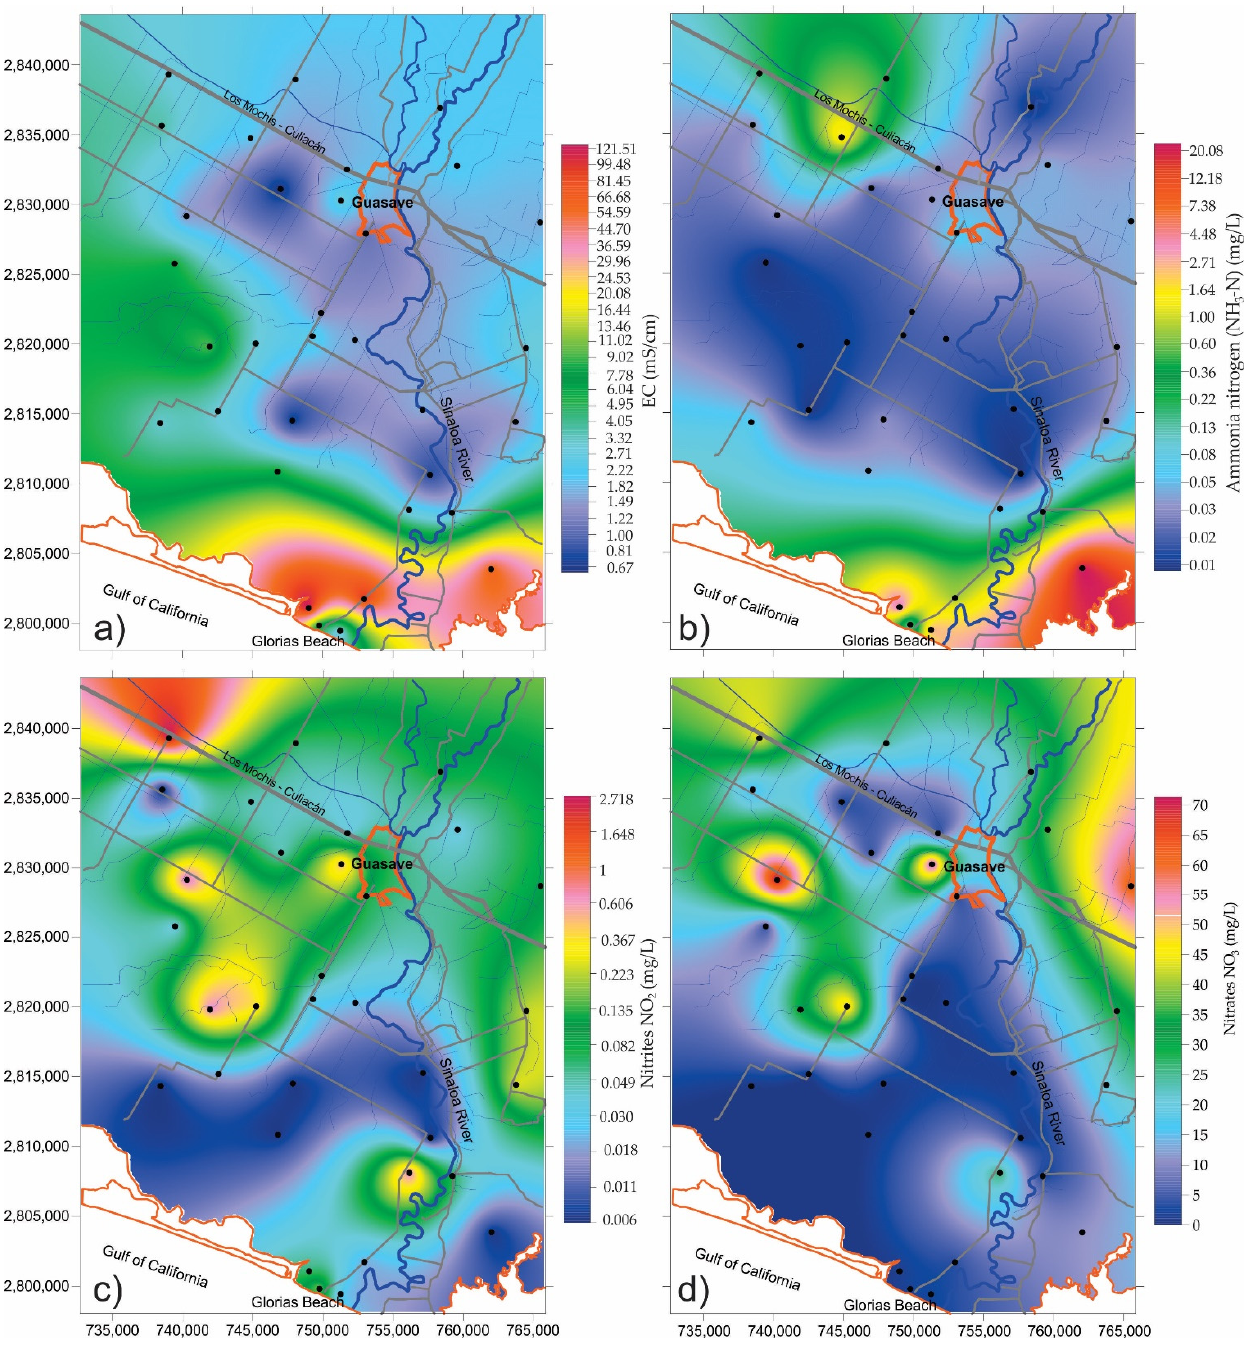
Figure 5. Behavior of ( a ) electrical conductivity (EC), ( b ) ammoniacal nitrogen, ( c ) nitrites and ( d ) nitrates present in groundwater in the study area.